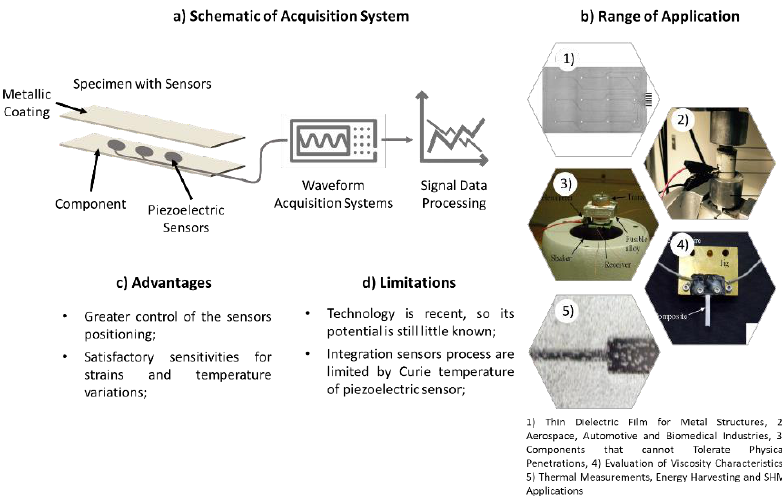
Figure 7. Piezoelectric sensors embedded into metal components.